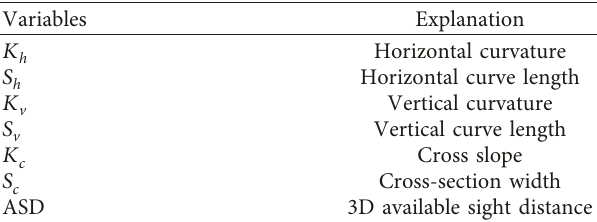
Table 3: Classification and explanation of input variables. Variables